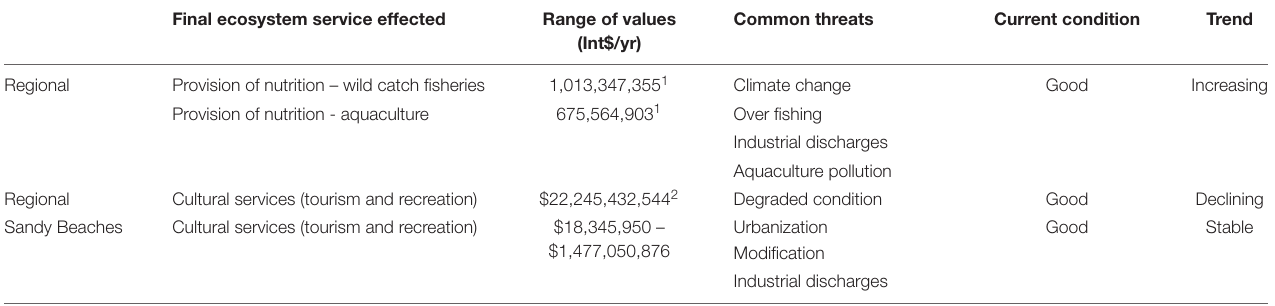
TABLE 1 | Summary of regional valuations for temperate Australia, the common threats, their current condition and trend.